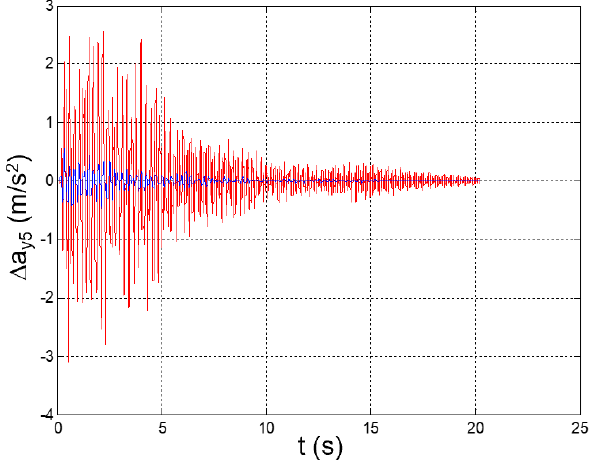
Figure 35. Seismic response, interstory acceleration at the 5th floor ( Δ 𝑎 y5 = 𝑎 y5 − 𝑎 y4 ).